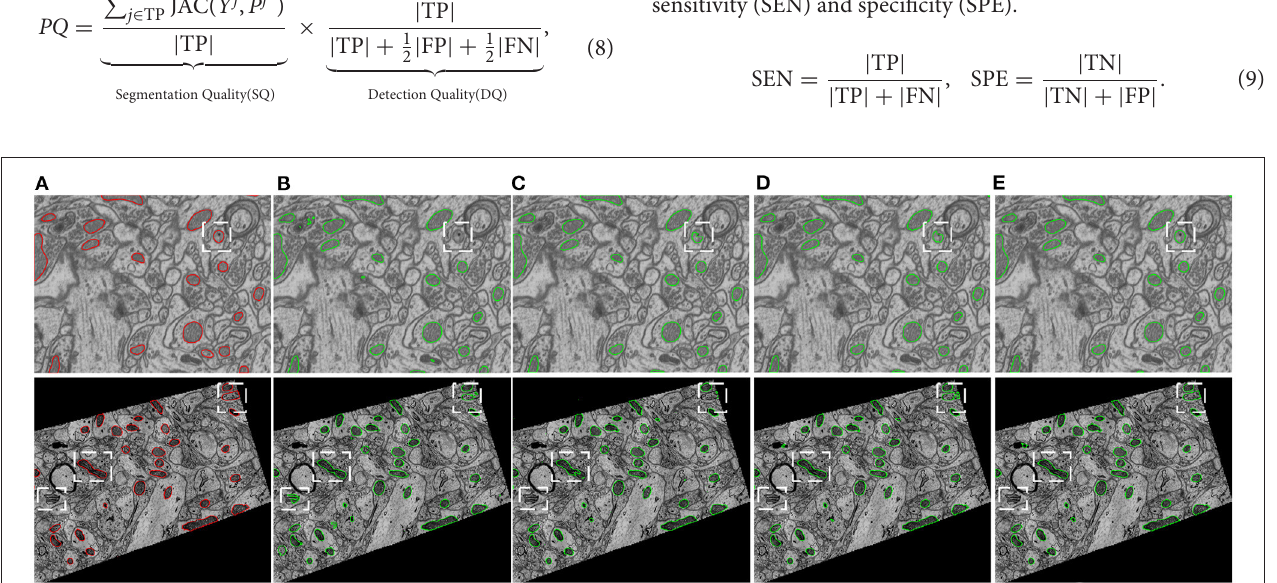
FIGURE 5 | Visual comparison of the proposed method with two strong baselines, i.e., 2D U-Net (Ronneberger et al., 2015) and 3D U-Net (Çiçek et al., 2016) and a state-of-the-art 3D model, i.e., HIVE-Net ( Yuan et al., 2021), on examples from the EPFL dataset and the Kasthuri++ dataset. (A) Ground truth, (B) 2D U-Net, (C) 3D U-Net, (D) HIVE-Net, (D) our.